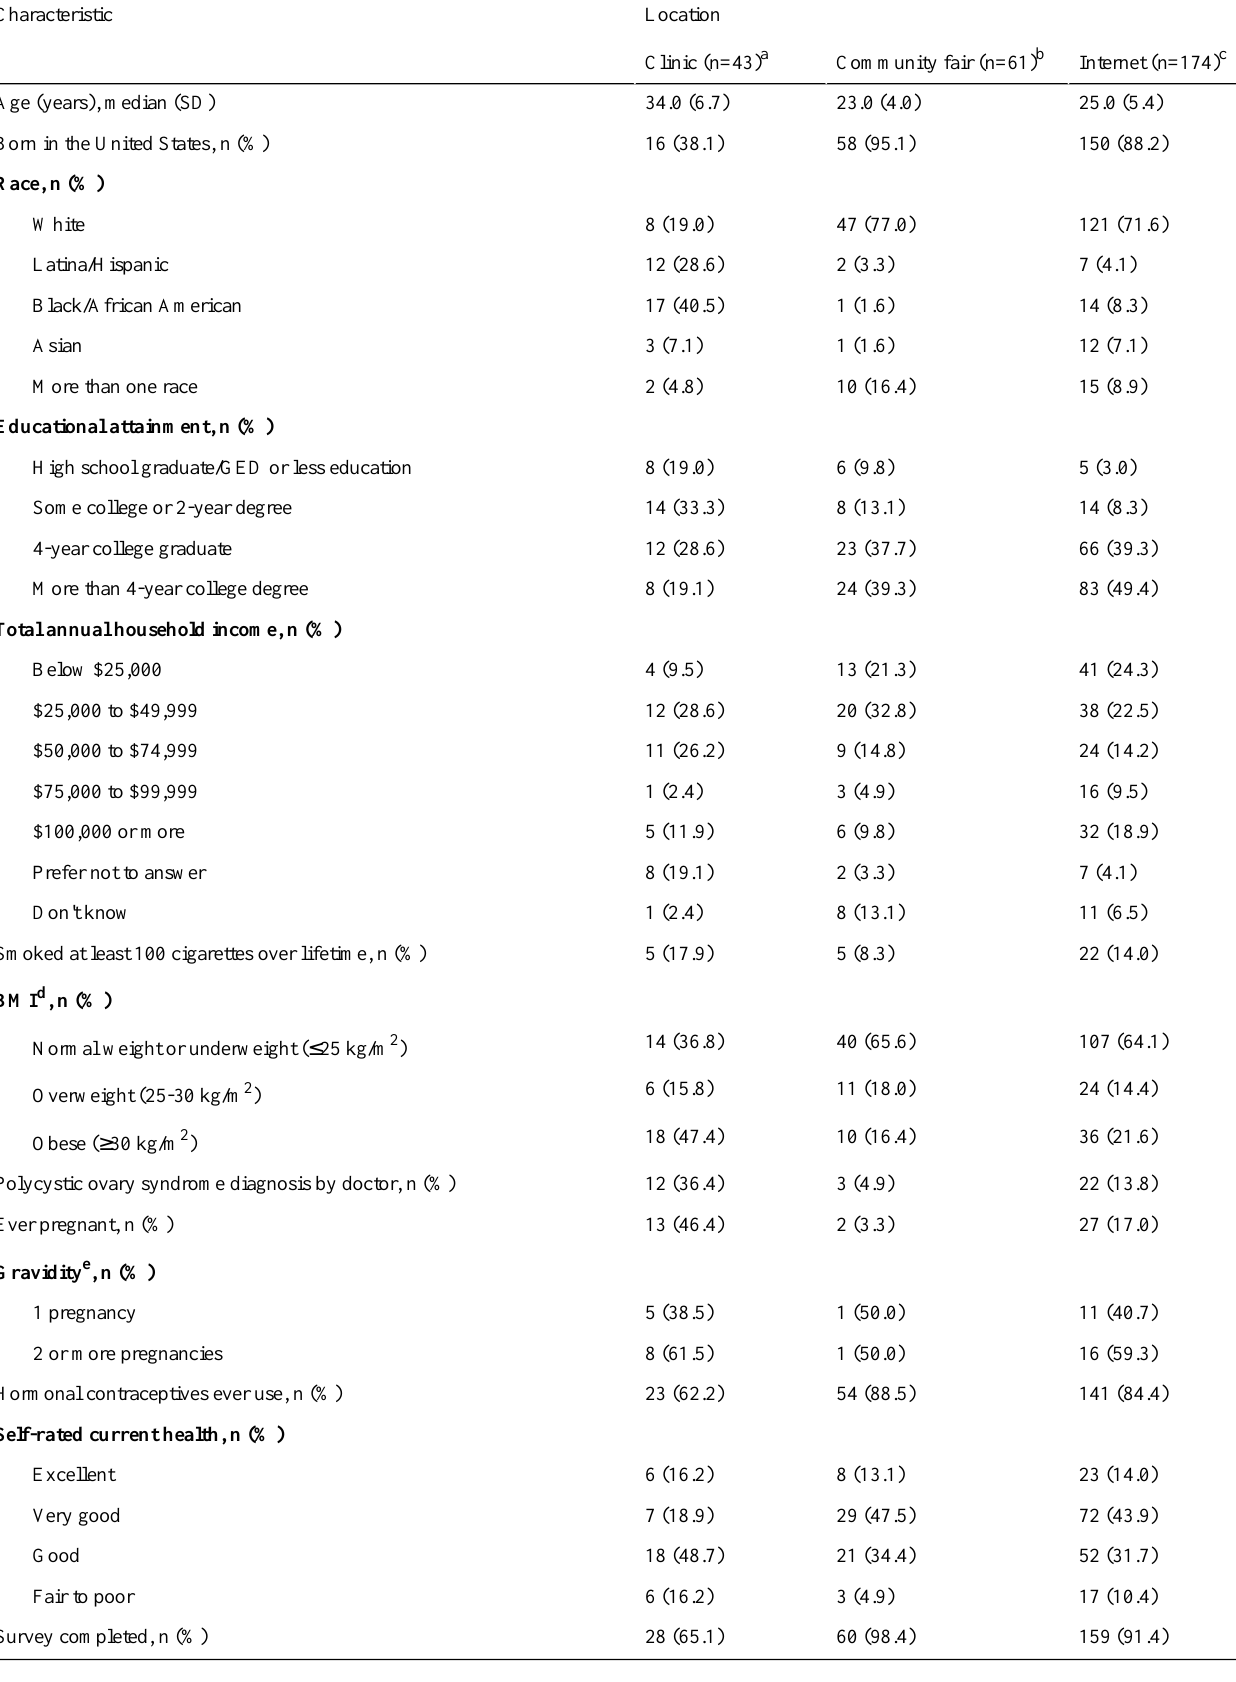
Table 2. Demographic characteristics by recruitment location.